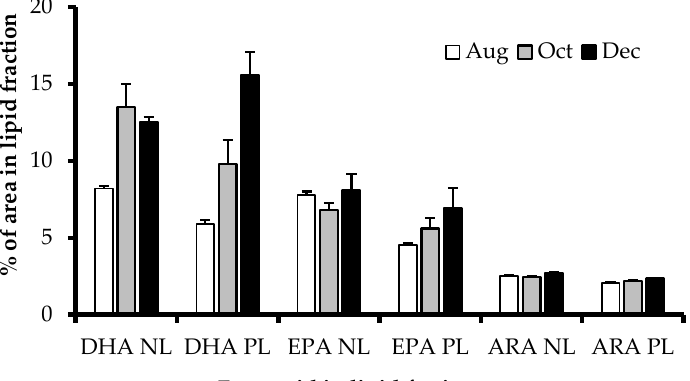
Figure 6. EPA, DHA, and ARA content in polar and neutral fraction of different spawning seasons at day 40 of larval culture.